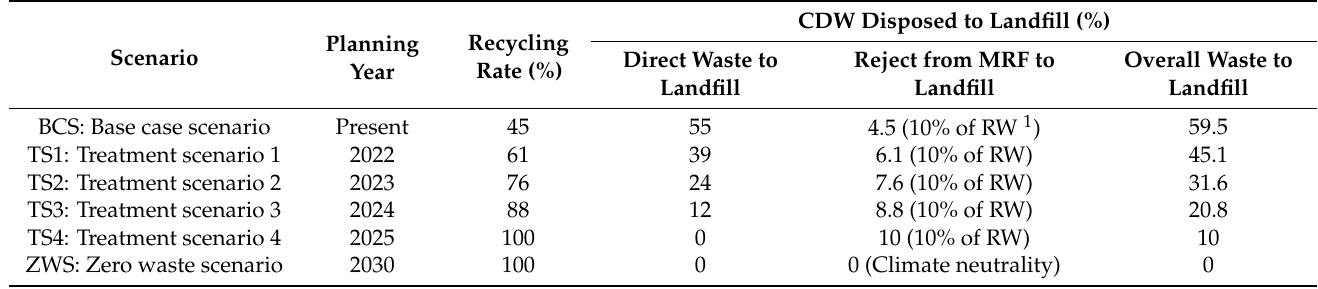
Table 2. Construction and demolition waste management scenarios for Riyadh City.